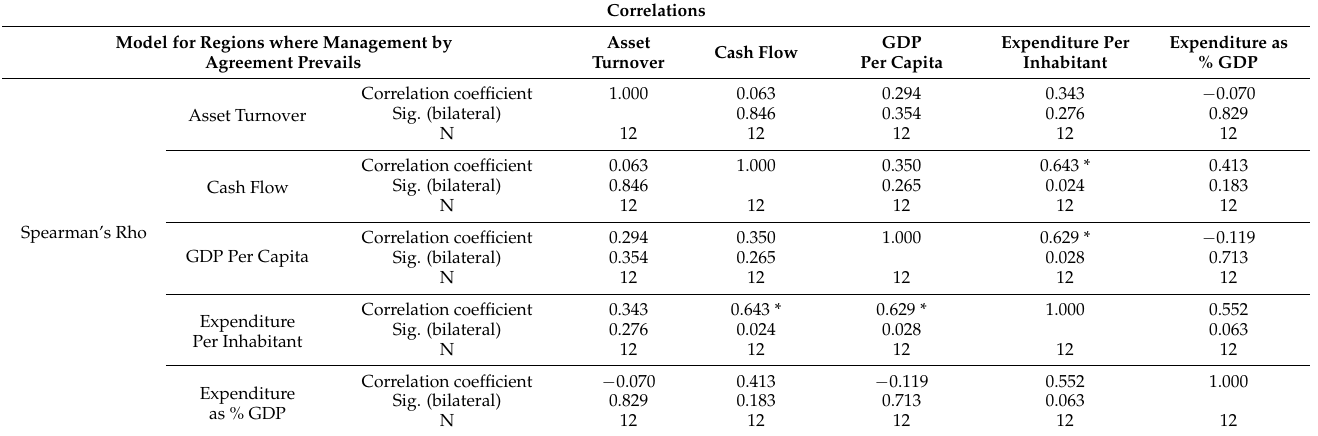
Table 5. Correlation matrix of variables for regions with management by agreement.